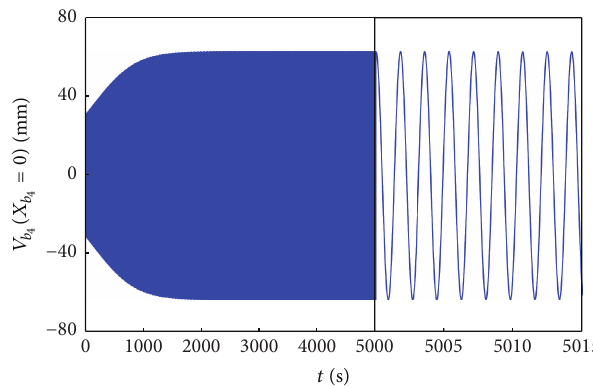
Figure 4: Time response of the midpoint of the deck beam, 𝑞 𝑟 (0) = 0.1𝛿 1𝑟 .